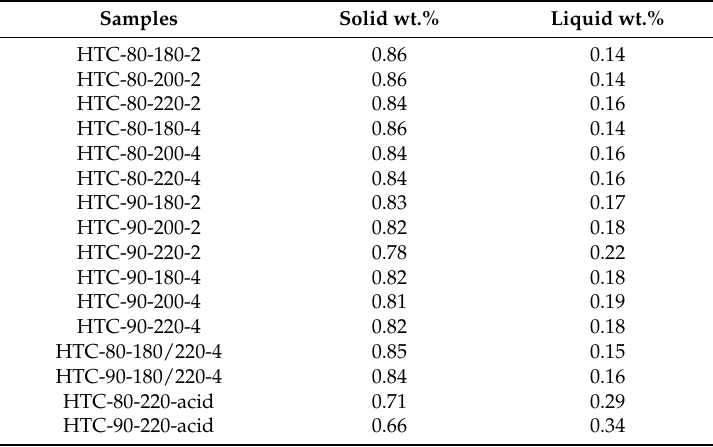
Table 3. Distribution of C into solid and liquid